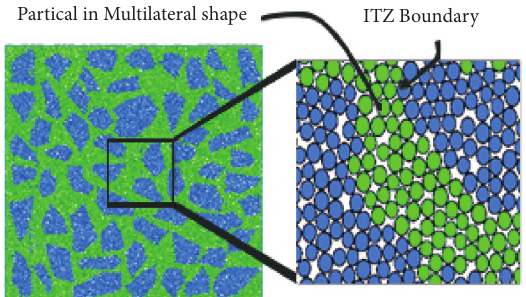
Figure 10: The blue particles are the aggregate clusters; the green particles are the filled mortar units.